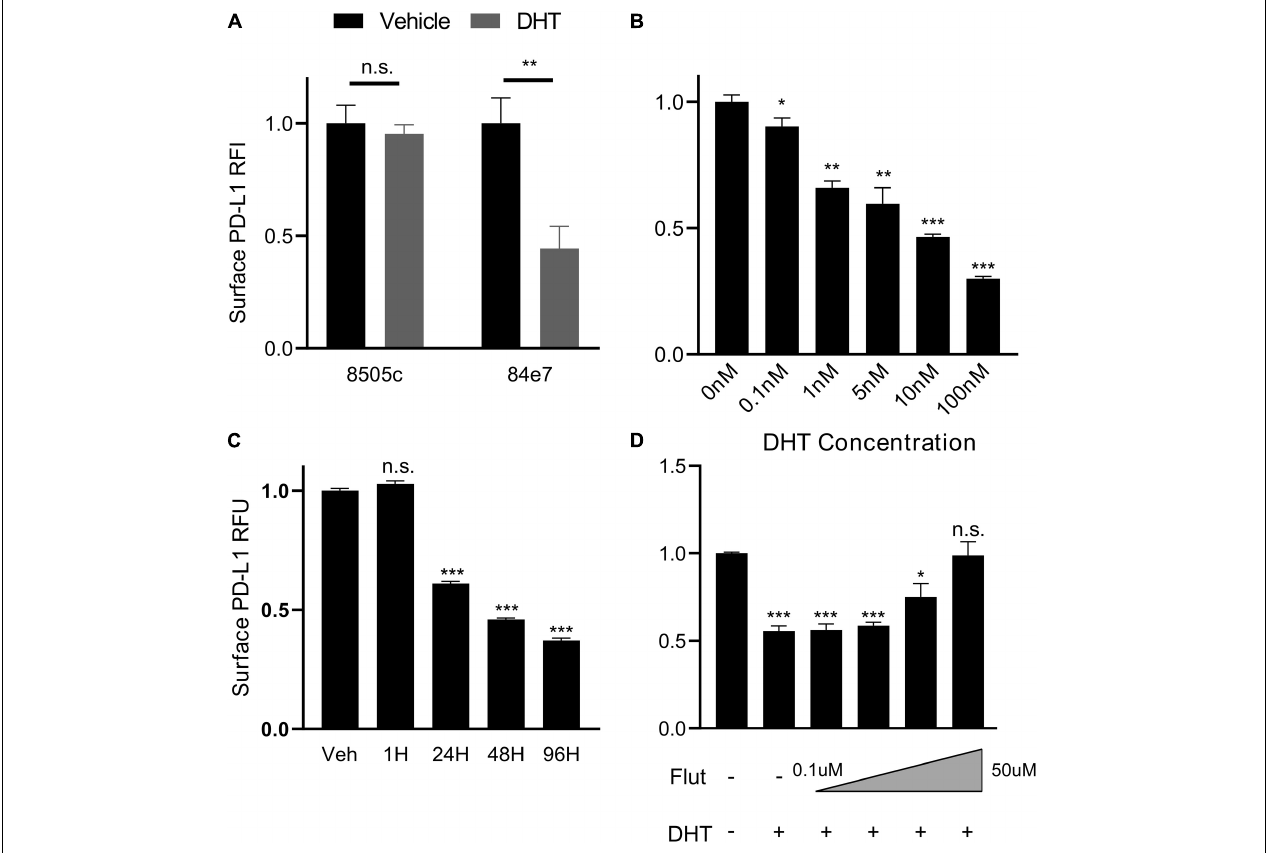
FIGURE 2 | PD-L1 is downregulated by androgen in an AR-dependent manner. (A) Surface expression of PD-L1 determined by flow cytometry in AR-lacking (8505C) or AR-expressing (84E7) thyroid cancer cell line after treatment with Vehicle (ethanol) or Dihydrotestosterone (DHT) (10 nM) for 72 h. (B) Dose-response to variable DHT concentrations in 84E7 cells at 72 h. (C) Time course of variable treatment lengths with 10 nM DHT. (D) Surface PD-L1 expression in 84E7 cell lines treated with 10 uM DHT and increasing concentrations of flutamide (Flut) at concentrations of 0.1, 1, 10, and 50 uM. RFI, relative fluorescence intensity. Student t -tests paired to control conditions * p < 0.05; ** p < 0.005; and *** p < 0.0005. Barplots represents mean ± SEM of experiments performed in triplicate. ns , not